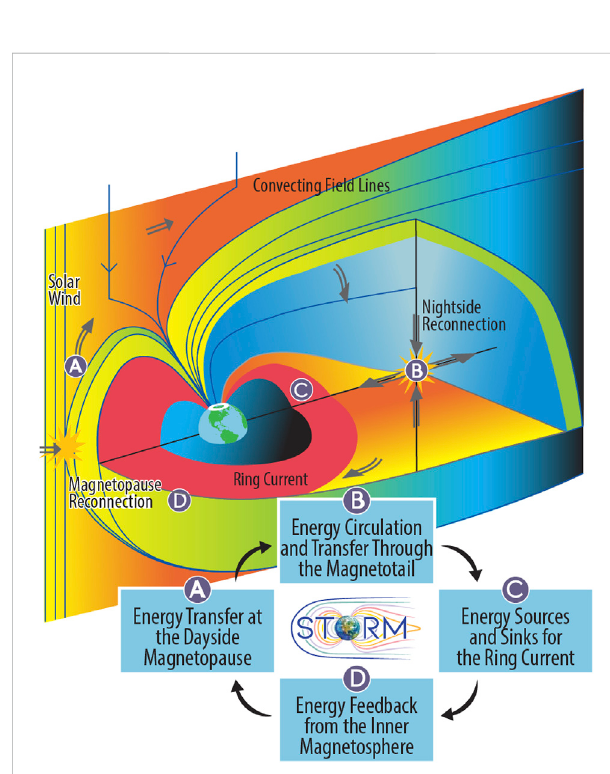
FIGURE 9 (top) An illustration of the Dungey Cycle and transfer and circulation of energy in the coupled solar wind-magnetosphere system. (bottom) STORMs four science objectives addressing this circulation of energy from the (A) dayside magnetopause and across the polar cap, (B) through the magnetotail, (C) into the inner magnetosphere, and (D) the subsequent feedback from the inner magnetosphere to the outer